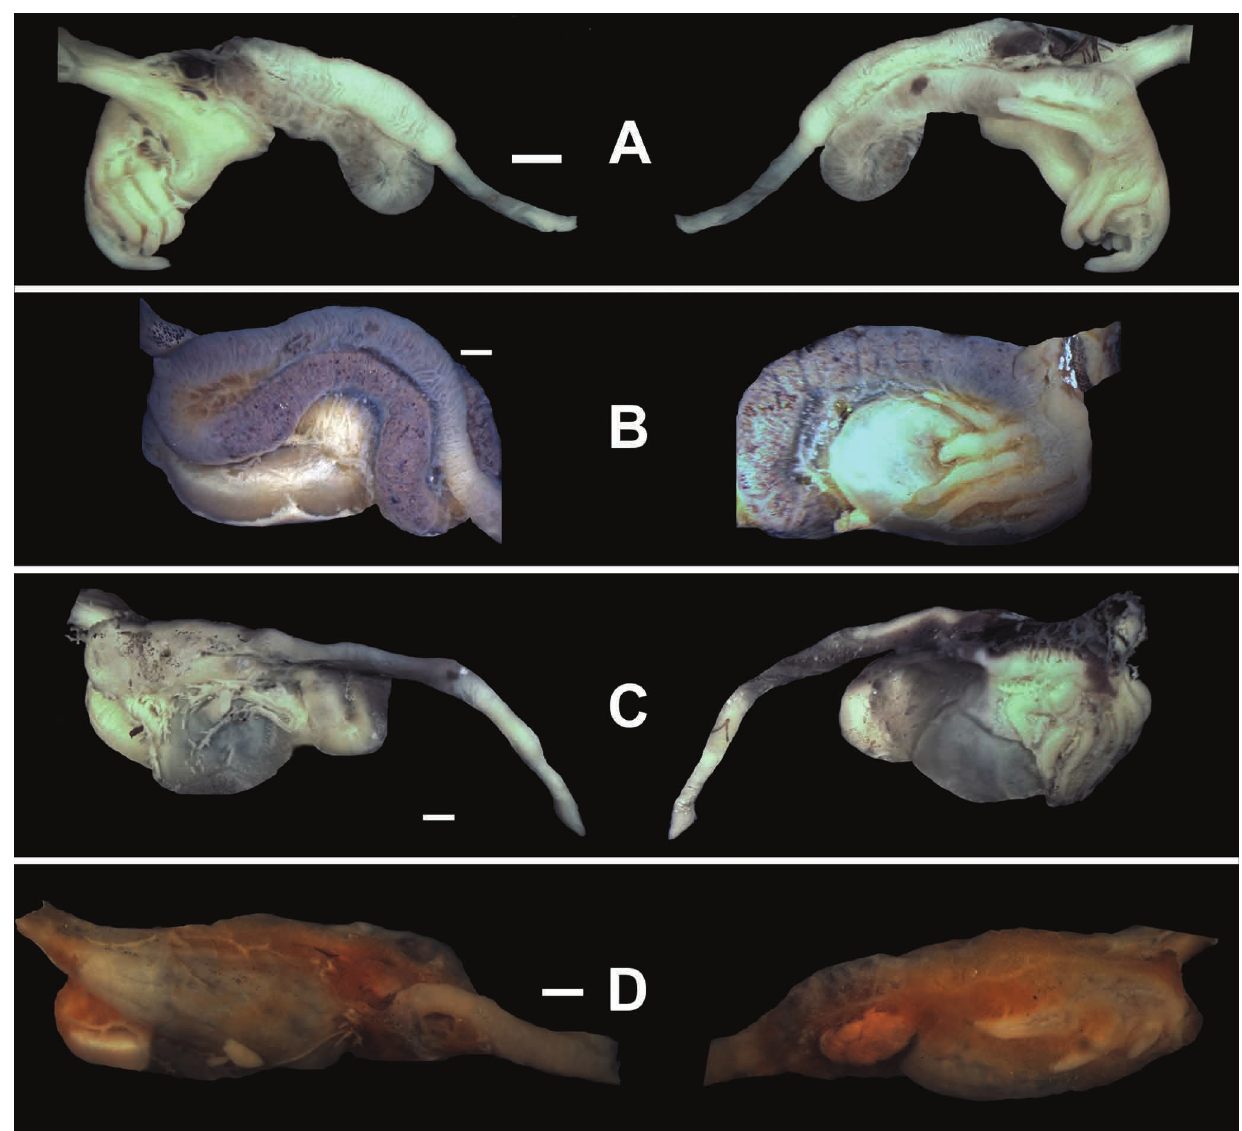
Fig. 2. Alimentary tract of selected species of the Characidae family: A - Gymnocorymbus ternetzi ; B - Bryconamericus thomasi ; C - Markiana nigripinnis ; D - Characidium borellii . Characters are indicated with numbers and character states between parentheses. Red bar indicates the anterior distal margin of the stomach.